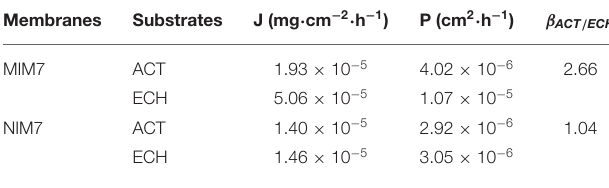
TABLE 4 | Time-permeation results (800min) of MIM7 and NIM7 for ACT and ECH. Membranes Substrates